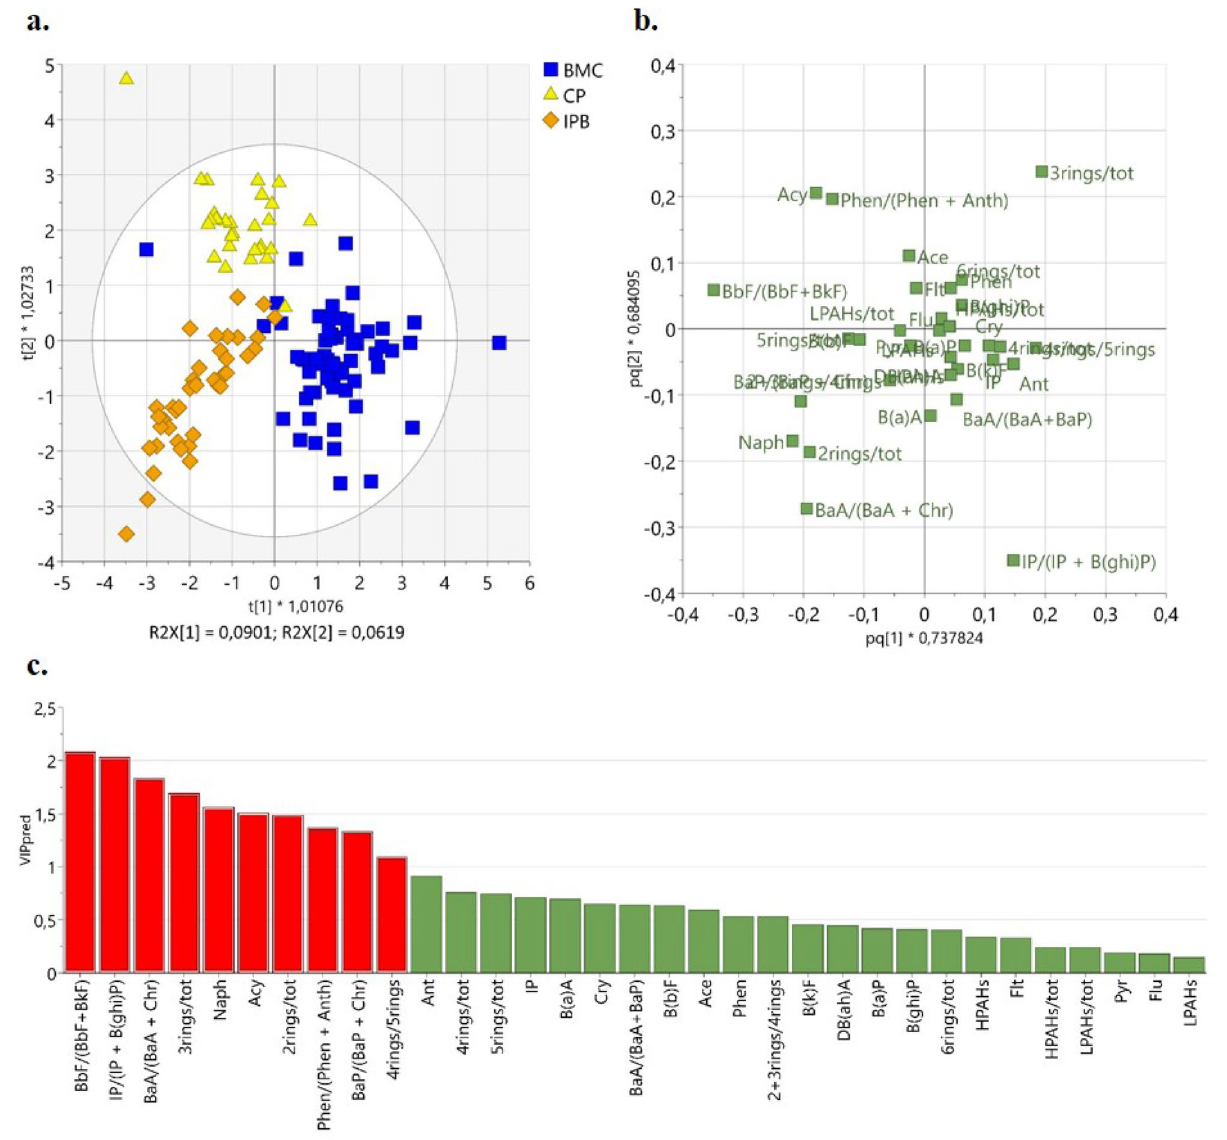
Figure 4. OPLS-DA applied on BMC (Mar Piccolo Basin), IPB (International relevance port), and CP (Commercial Port) samples: t1/t2 score plot ( a ) and pq1/pq2 loading plot ( b ), relative to the two predictive components; Predictive VIP plot ( c ) (variables with VIP value > 1 are marked in